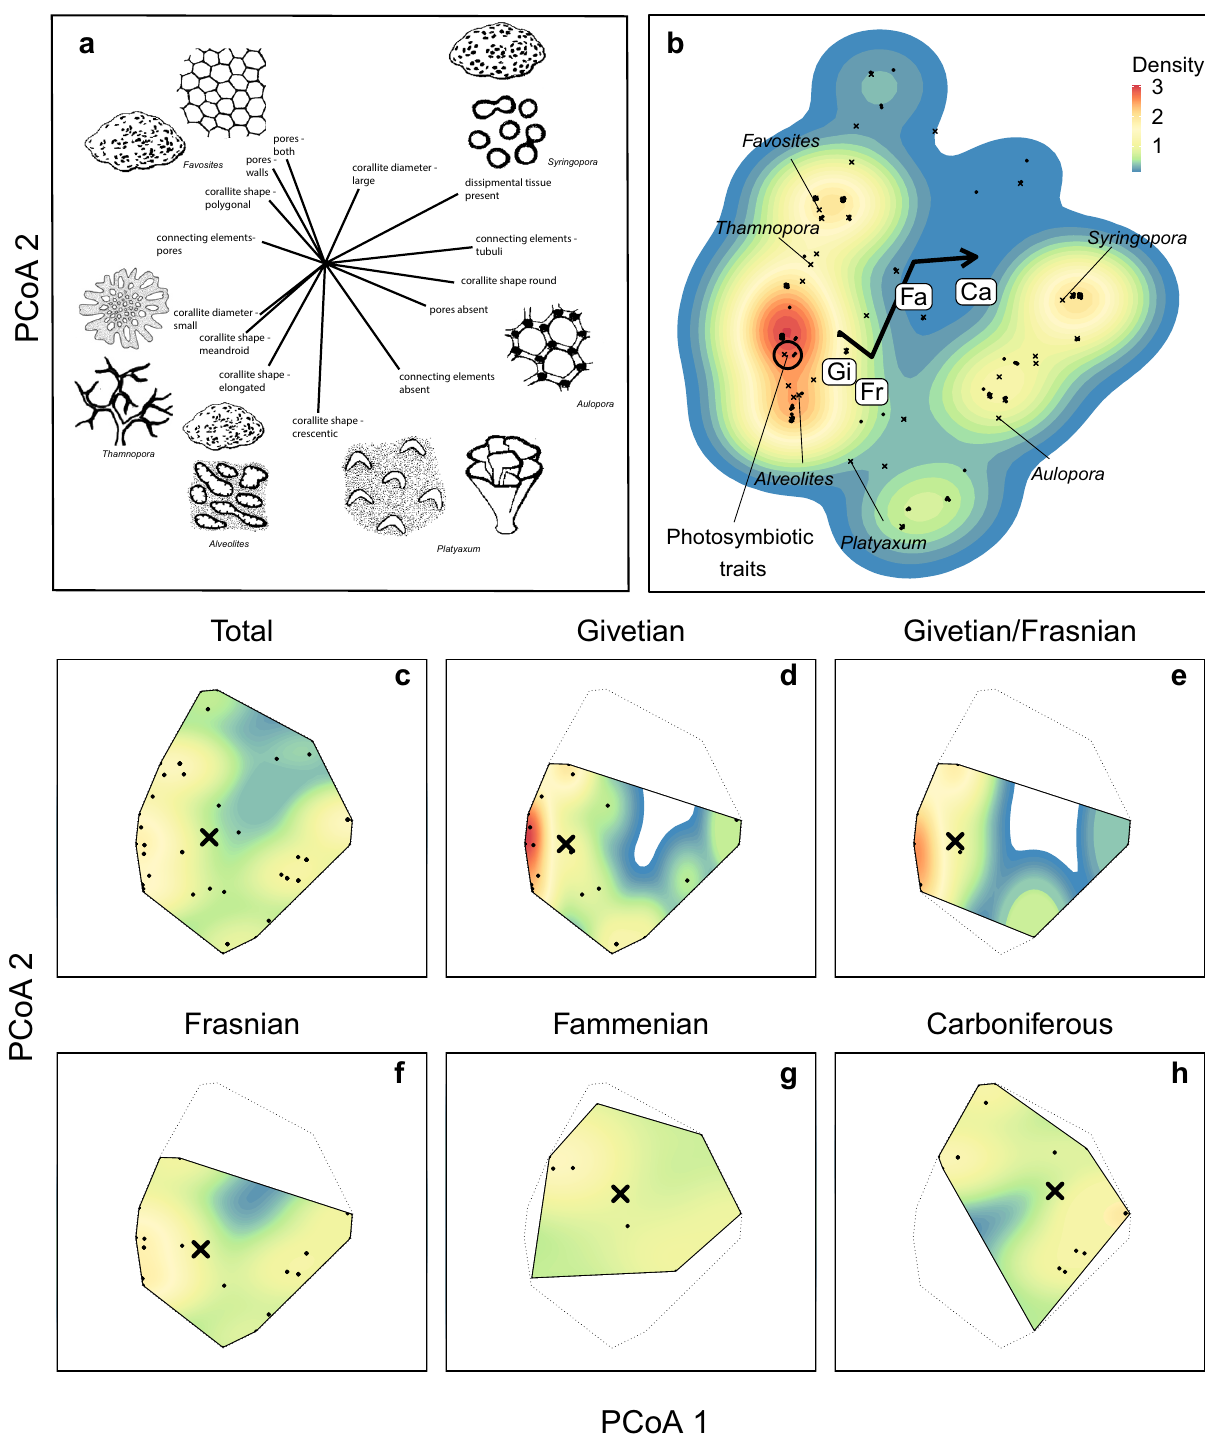
Figure 2. Trait space for Devonian and early Carboniferous tabulate corals; ( a ) Vectors associated with trait space for Devonian tabulates, showing features of corals associated with each part of the trait space; ( b ) trait space for the entire study period. Colours indicate the density of species (i.e. functional redundancy) in each area of trait space. Letters indicate the centroid of the trait space in each time period: Gi = Givetian, Fr = Frasnian, Fa = Fammenian; Ca = Carboniferous; ( c – h ) functional richness of tabulate corals during each time period relative to the total for the entire study period. Dotted lines represent the proportion of the total traitspace occupied in each time period. Points represent the location of each species in the trait space Crosses indicate the centroids of each genus. The most dominant genera are named to indicate their location in the